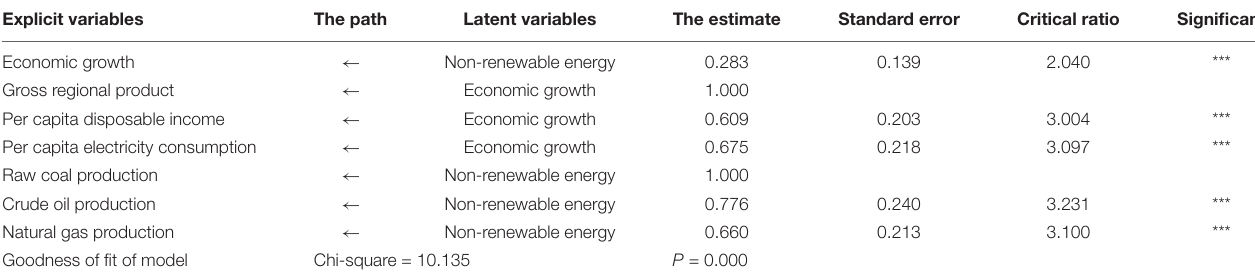
TABLE 4 | Parameter estimation of the structural equation of the impact of non-renewable energy development on regional economic growth.